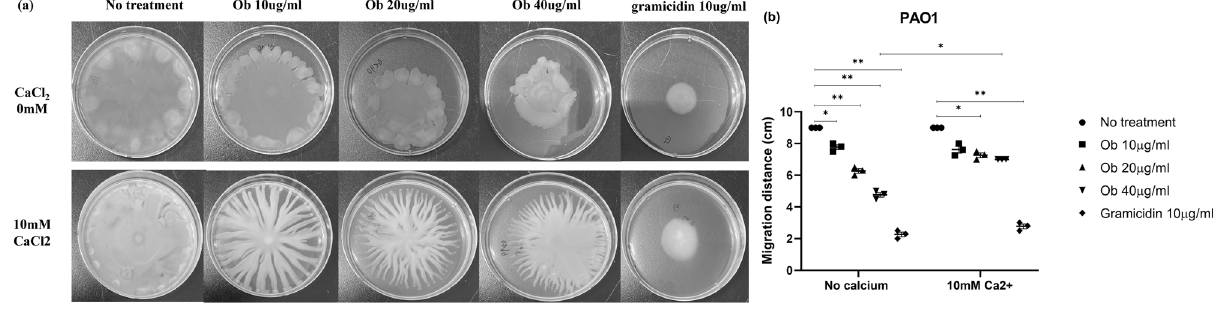
Fig. 9 Suppression of motility of P. aeruginosa strain PAO1 by Ob. a Motility analysis was performed using semisolid agar plates containing Ob at various concentrations. P. aeruginosa strain PAO1 was inoculated into the center of the semisolid agar containing Ob. b The migration distance (cm) was measured and recorded after the inoculated plates were incubated at 37 °C. The error bars represent the means and standard deviations (SDs). Statistical analysis was performed using unpaired two-tailed student t -test. Data are mean ± SEM for n = 3 biologically independent experiment. * p < 0.05, ** p < 0.005, *** p < 0.0005, **** p <